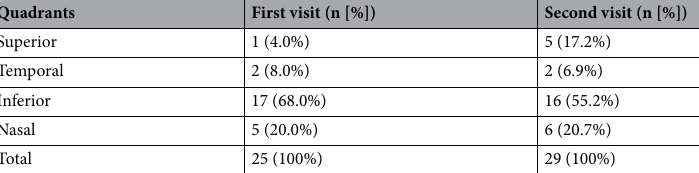
Table 2. Location of the Weiss ring at the first and second visits in group W. Among the 36 eyes in group W, 11 eyes at the first visit and 7 eyes at the second visit had Weiss ring outside the scan circle.